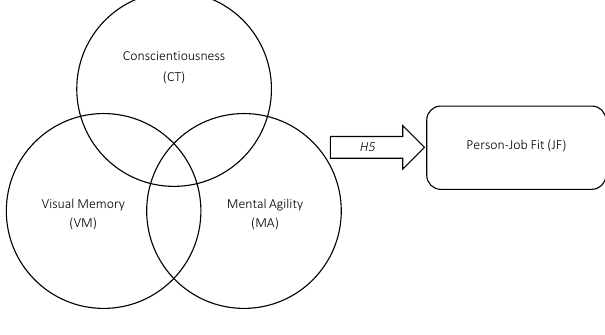
Figure 2. Configurational